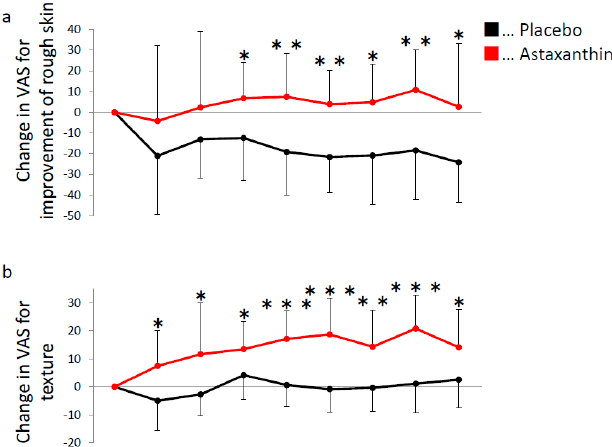
Figure 4. Subjective skin conditions “improvement of rough skin” and “texture” are improved by dietary supplementation with astaxanthin. Change in VAS score for “improvement of rough skin” ( a ) and “texture” ( b ) from baseline at the non-irradiated area in the placebo group (black) and astaxanthin group (red). Positive and negative numbers indicate improvement and deterioration, respectively. * p < 0.05, ** p < 0.01 and *** p < 0.001 by unpaired t -test. Error bars indicate the SD.